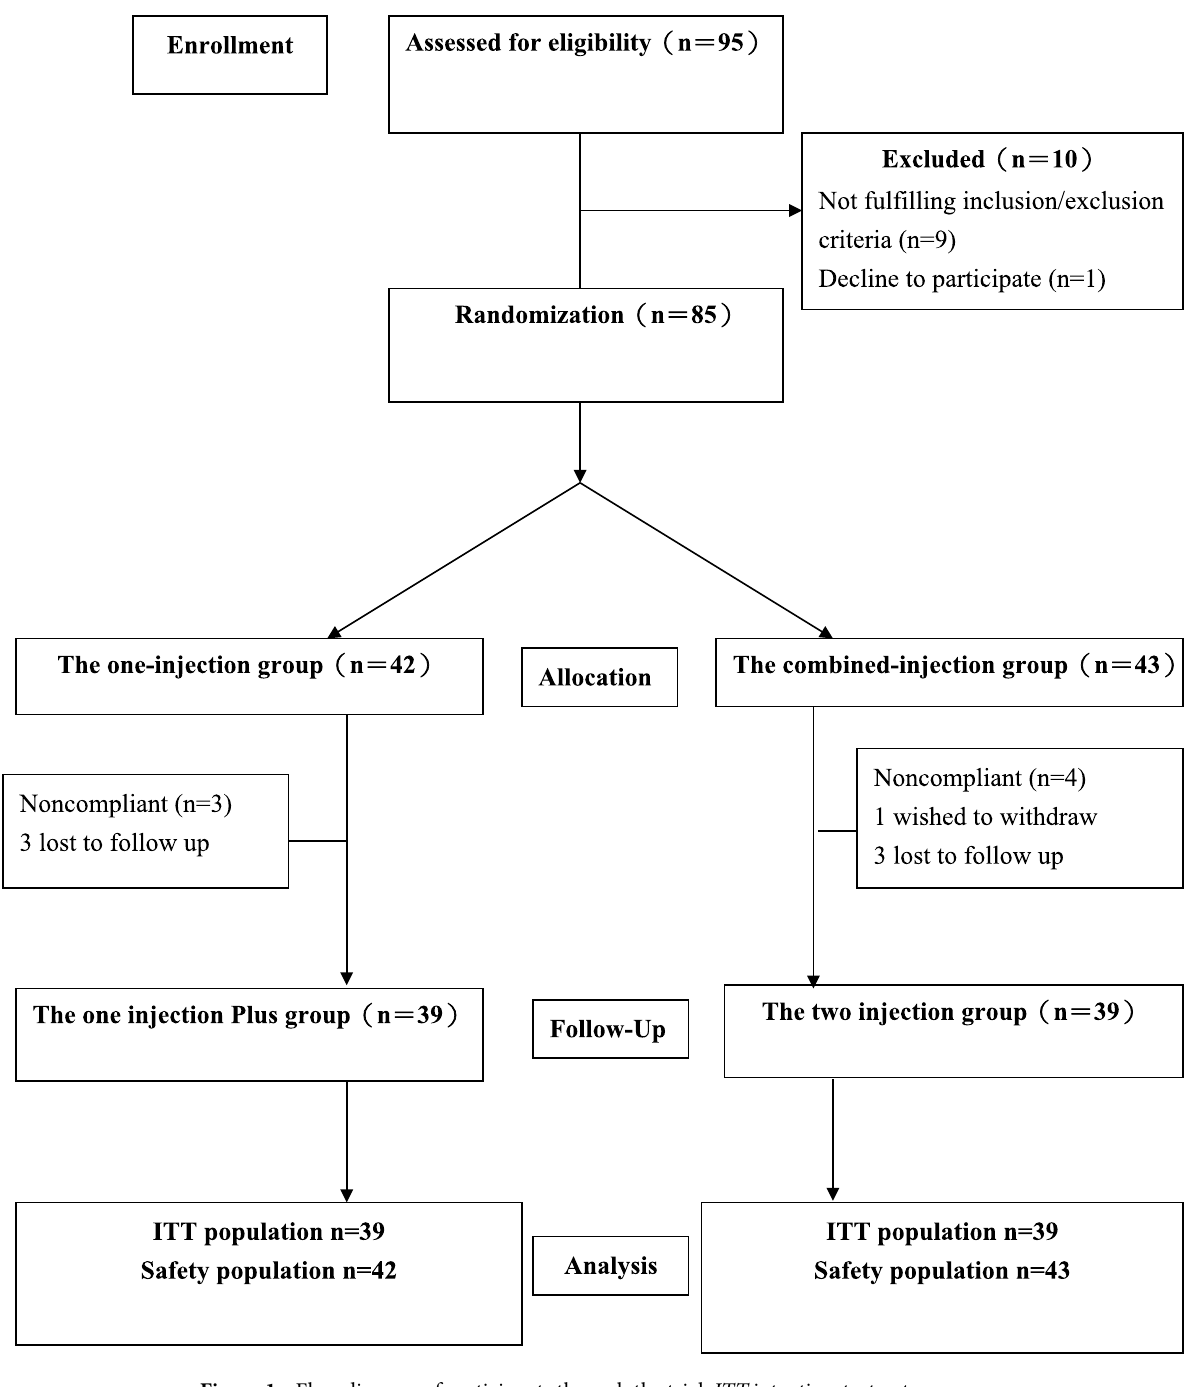
Figure 1. Flow diagram of participants through the trial, ITT Primary and secondary outcomes. Both groups showed significant improvements in VAS pain, WOMAC (including 3 subscale scores and total scores), Lequesne index scores and SLS among baseline, 1, 3, and 6 months after injections (p < 0.001) (Tables 3 and 4). The mean VAS scores improved by 21.9 mm, 25.8 mm and 20.4 mm from baseline at 1, 3 and 6-month follow-ups in the one-injection group, whereas the VAS scores improved by 18.1 mm, 28.1 mm and 31.8 mm from baseline in the combined-injection group (Table 3). Between-group comparison showed that patients receiving one injection of PRP experienced significantly greater VAS pain reduction than patients receiving combined injections at 1-month follow-up (adjusted mean difference: -5.6; p = 0.017) (Table 3). However, at 6-month follow-up, the combined-injection group achieved significantly better VAS pain reduction than the one-injection group (adjusted mean difference: 7.9; p = 0.020). Additional Johnson-Neyman analyses revealed the region of significance between the two groups at 3 months (Table 3, Fig. 2). In patients with baseline VAS